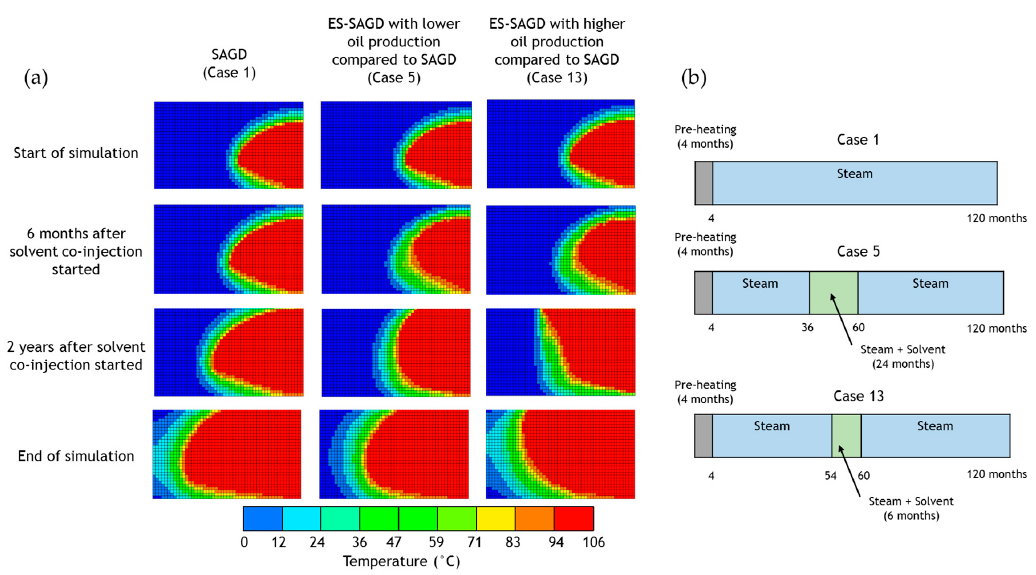
Figure 15. ( a ) Temperature distribution at four different moments during the simulation of three cases at which hexane at 10% mole was co-injected using cycles of different duration. ( b ) Timing and duration of the steam and solvent cycles for each case.